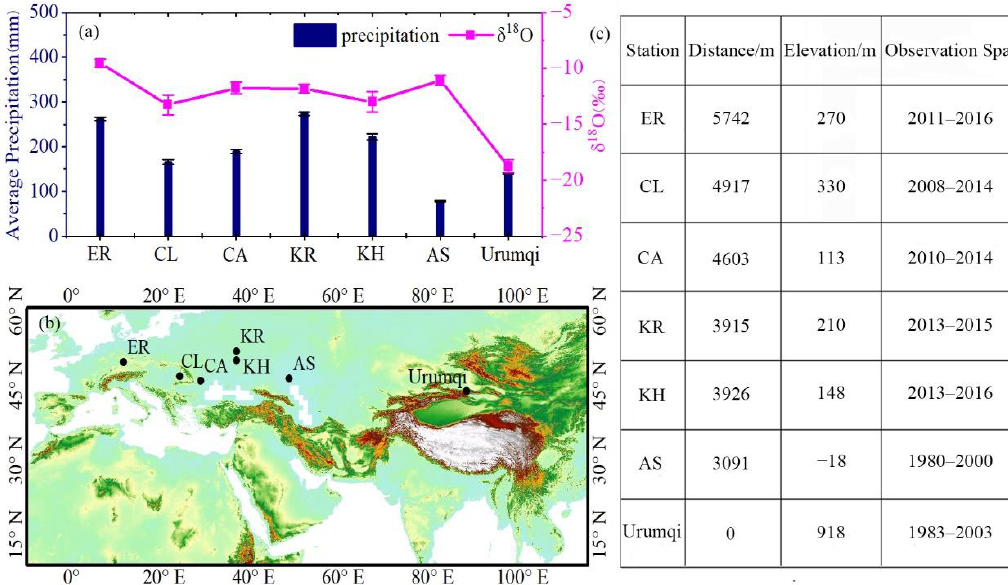
Figure 8. ( a ) Changes on average δ 18 O and precipitation during the snow season in ER (Erlangen), CL (Cluj), CA (Cahul), KR (Kursk), KH (Kharkhiv), AS (Astrakhan) and Urumqi. ( b ) The spatial distribution of ER, CL, CA, KR, KH, AS and Urumqi. ( c ) The elevation, distance to Urumqi and observation span information of ER, CL, CA, KR, KH, AS and Urumqi.